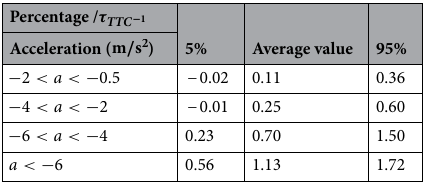
Table 4. Range of safety indicators ( s − 1 ) 24 .